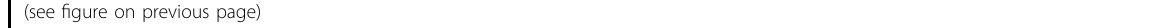
Fig. 3 Regulation of X chromosome reactivation by histone modi fi cations in female hPGCs. a Boxplot showing the comparison of DNA methylation levels at chrX gene (green) and other chromosome gene (bright blue) promoters in hPGC and gonadal somatic cell (Soma) samples. b Boxplots showing the comparison of H3K4me3 pro fi les on chrX CpG-island (CGI) promoters and other promoters in hPGCs of both sexes at early and late stage. Pro fi les were calculated as ChIP-seq RPM. c Barplot showing the proportion of total expression levels on chrX genes/all genes in male and female hPGCs at indicated stages. d Boxplots showing the comparison of H3K27me3 pro fi les on chrX CGI promoters and other promoters in hPGCs of both sexes at early and late stage. e Boxplots showing the comparison of H3K9me3 pro fi les on chrX CGI promoters and other promoters in hPGCs of both sexes at early and late stage. f Genome browser view of H3K4me3, H3K27me3 and H3K9me3 pro fi les on X reactivated gene IDS . Pro fi les were calculated as ChIP-seq RPM and smoothed as 3 pixels window using WashU Epigenome Browser. g Barplot showing IDS expression in hPGCs of both sexes at early and late stage. h Genome browser view of H3K4me3 and H3K27me3 pro fi les on lncRNA XACT. Pro fi les were calculated as ChIP-seq RPM and smoothed as 3 pixels window using WashU Epigenome Browser. i Barplot showing XACT expression in hPGCs of both sexes at early and late stage. For male, Wk8 – 9, Wk15 and Wk23 hPGC samples are represented as early, middle and late stage, respectively; for female, Wk8 – 10, Wk14 and Wk21 hPGC samples are represented as early, middle and late stage, respectively. CGI-promoters listed on chrX in ( b , d and e ) are cited from SRP057098. F female, M male. Student ’ s t test is performed to examine the signi fi cant statistical difference between two groups of data in boxplots in ( b , d and e ). ** P < 0.01, *** P < 0.001, n.s. not signi fi